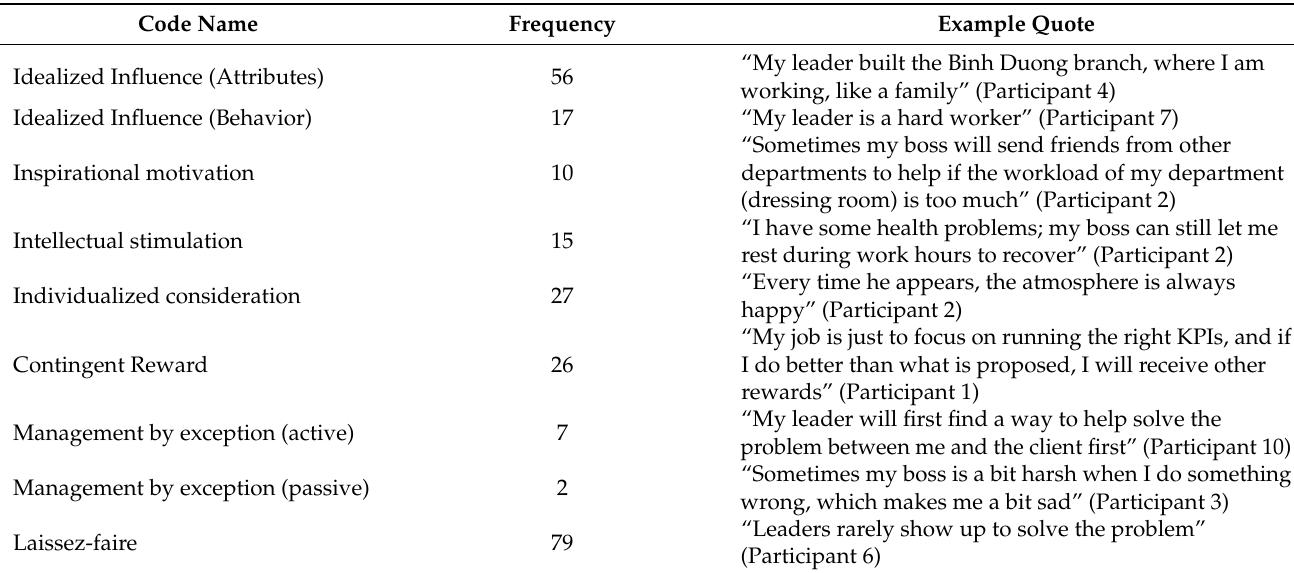
Table 3. Sample illustration of the coding node.